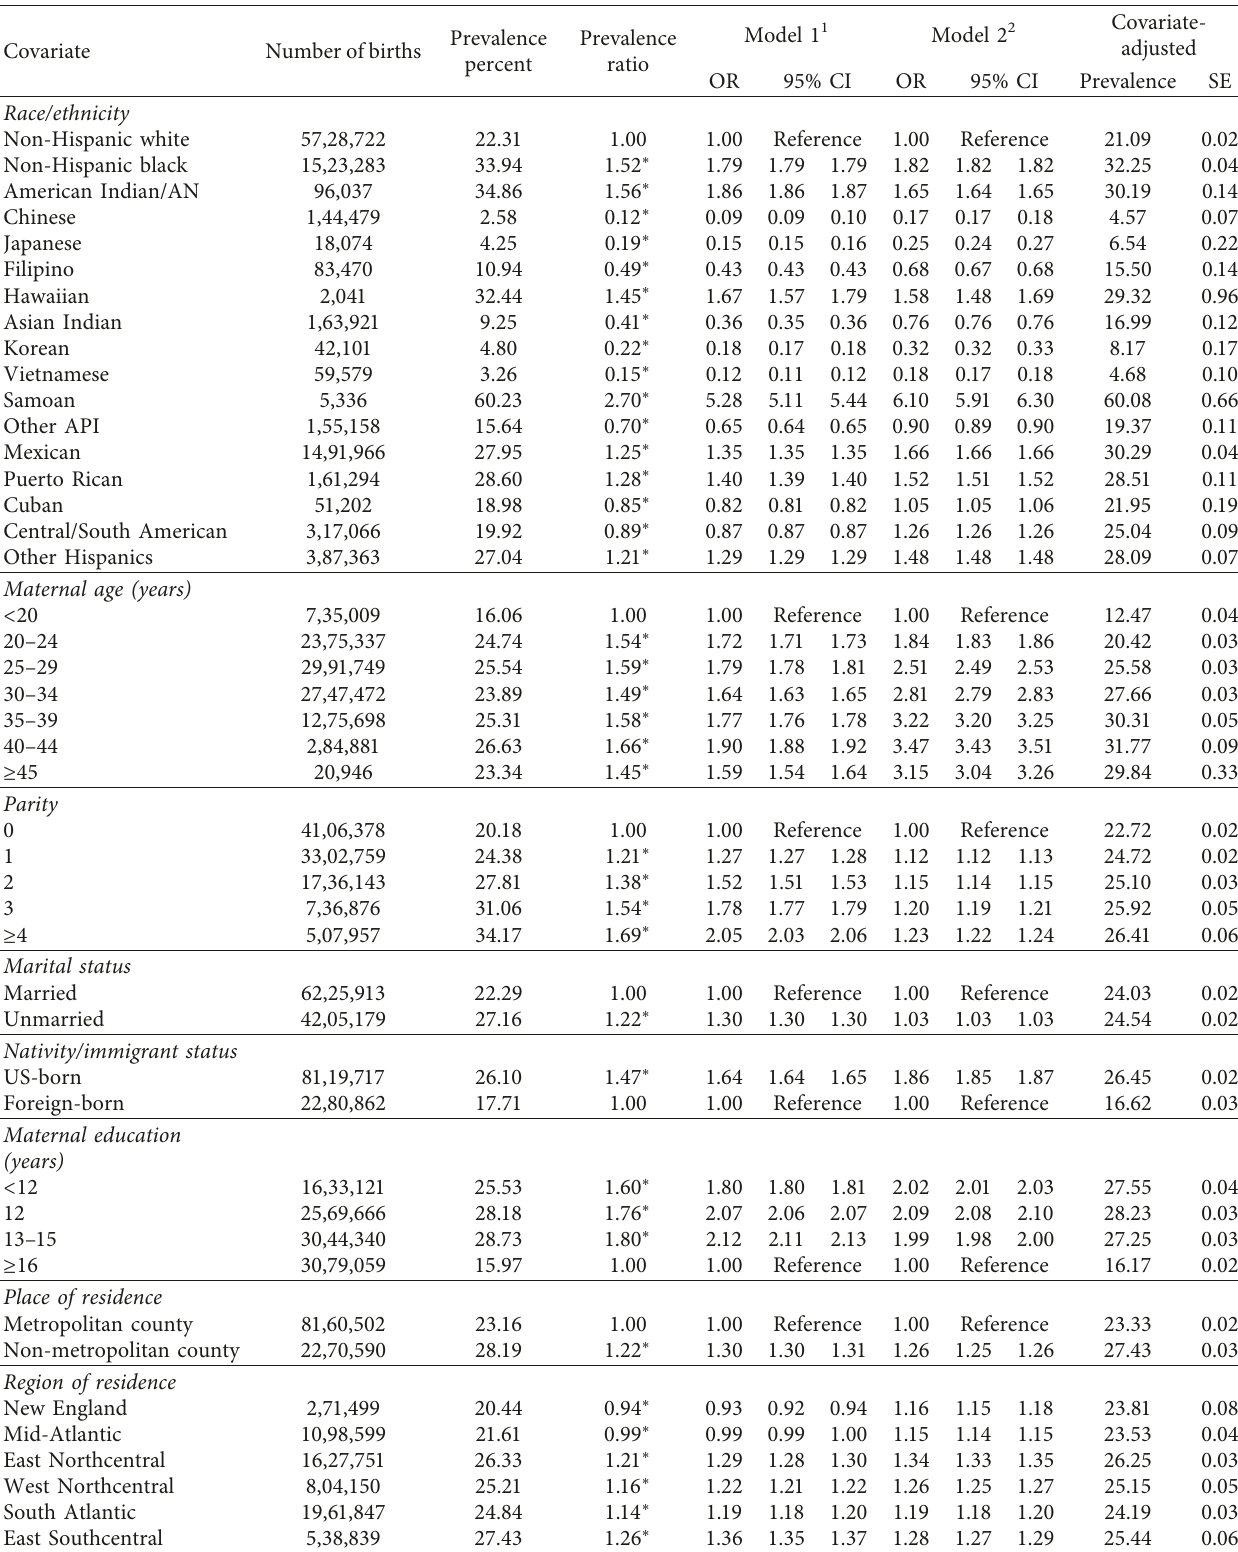
Table 1: Observed prevalence and logistic regressions showing unadjusted and covariate-adjusted differentials in pre-pregnancy obesity (BMI ≥ 30) among reproductive-age women in major racial/ethnic groups and by selected sociodemographic characteristics, United